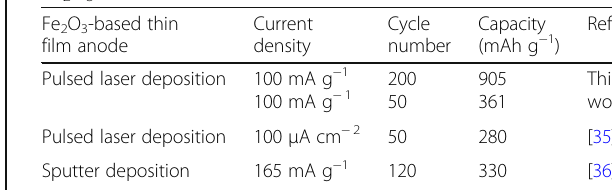
Table 1 The capacity comparison of our work with reported